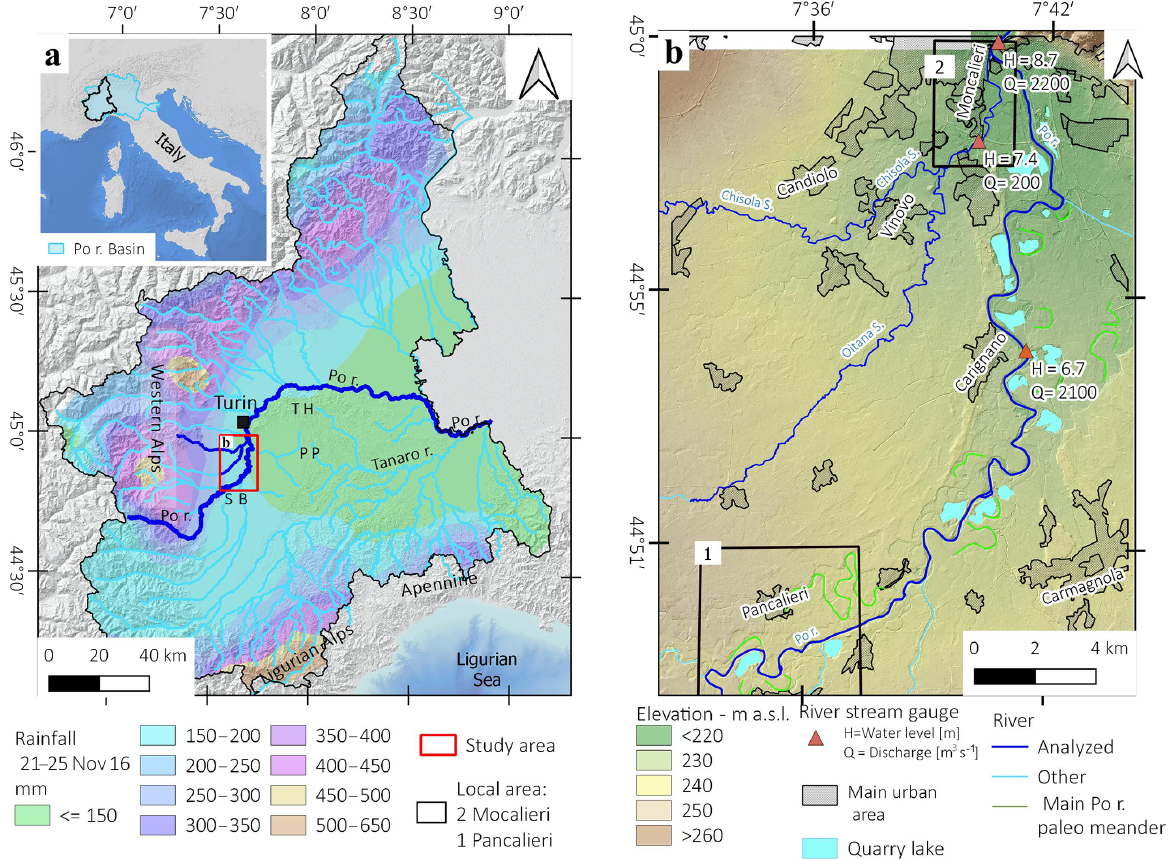
Figure 1. (a) Location of Piedmont region in Italy; (a) rainfall in Piedmont region during the 21–25 November flood event (based on ARPA Piemonte data) and location of study area (SB = Savigliano Basin, PP = Poirino Plateau, TH = Turin Hills) (b) Detailed view of the study area with discharge in the stream gauge stations and the location of Pancalieri (1) and Moncalieri (2) local areas case